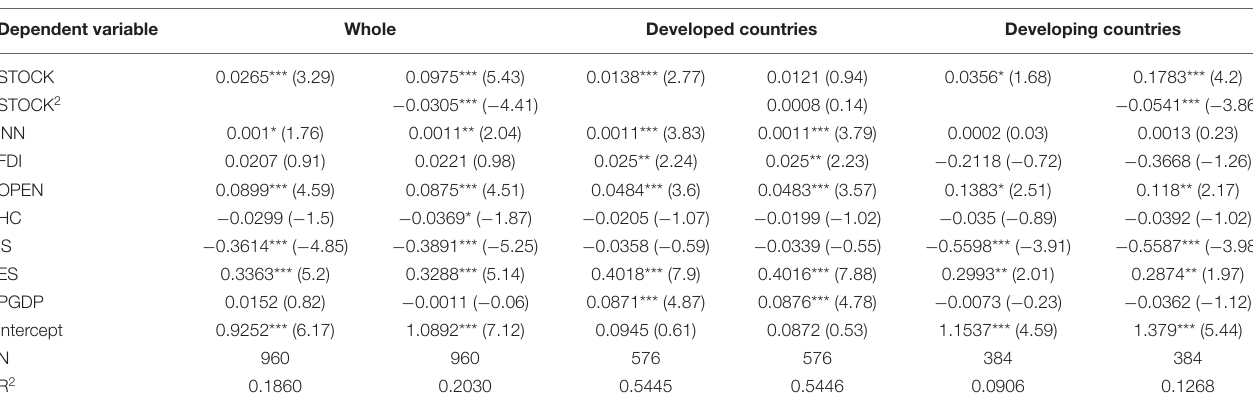
TABLE 4 | Estimation of the impact of securities development on